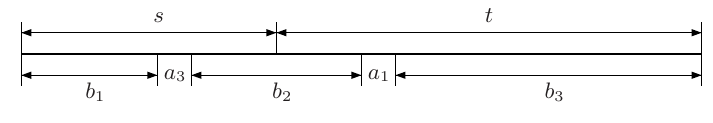
Fig. 1. Structure of b in Subcase